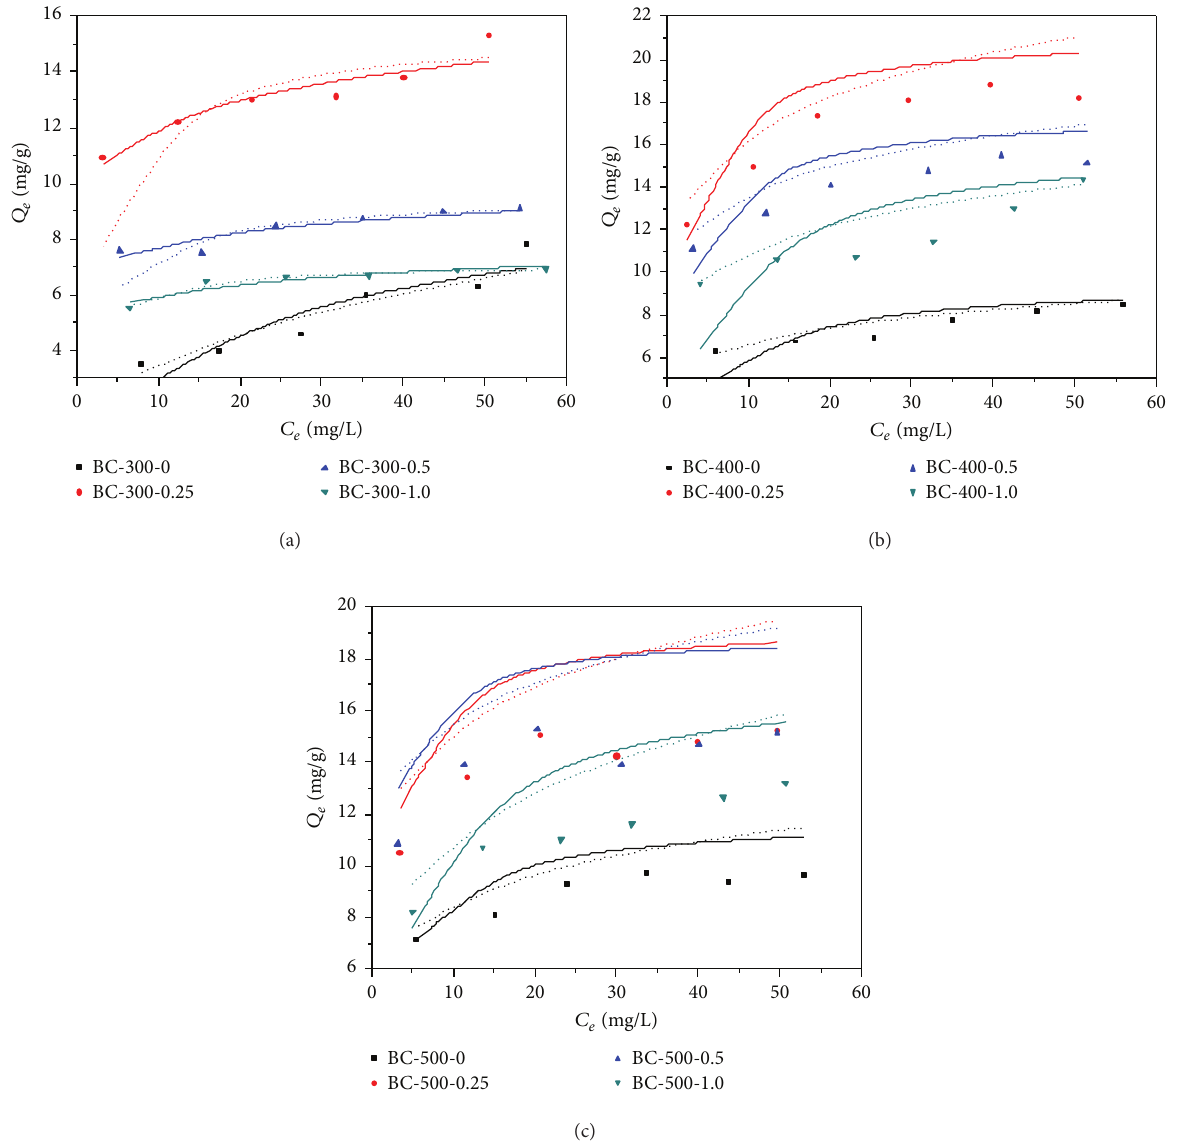
Figure 3: Sorption isotherms of Ni(II) on the BCs. (a) BC-300- 𝑌 samples; (b) BC-400- 𝑌 samples; (c) BC-500- 𝑌 samples.